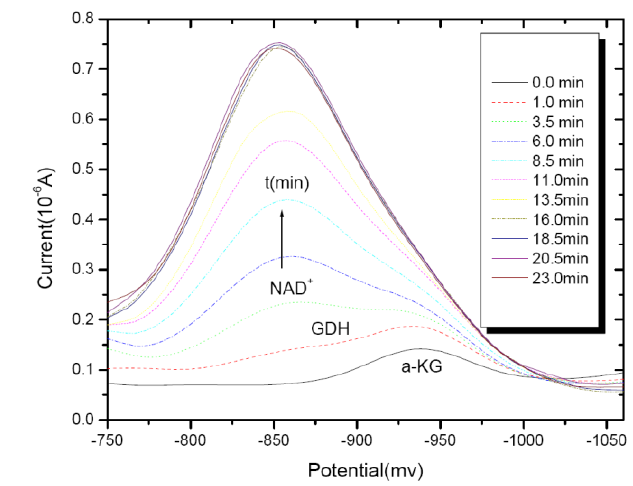
Figure 10. Differential-pulse polarography of GDH enzyme system; in a 0.1 M pH = 6.5 Tris-HCl buffer solution; 0.002 M α-KG; 0.0002 M NADH; 0.01 M NH Scan rate: 5 mV/s. Reprinted from reference [47] with permission from